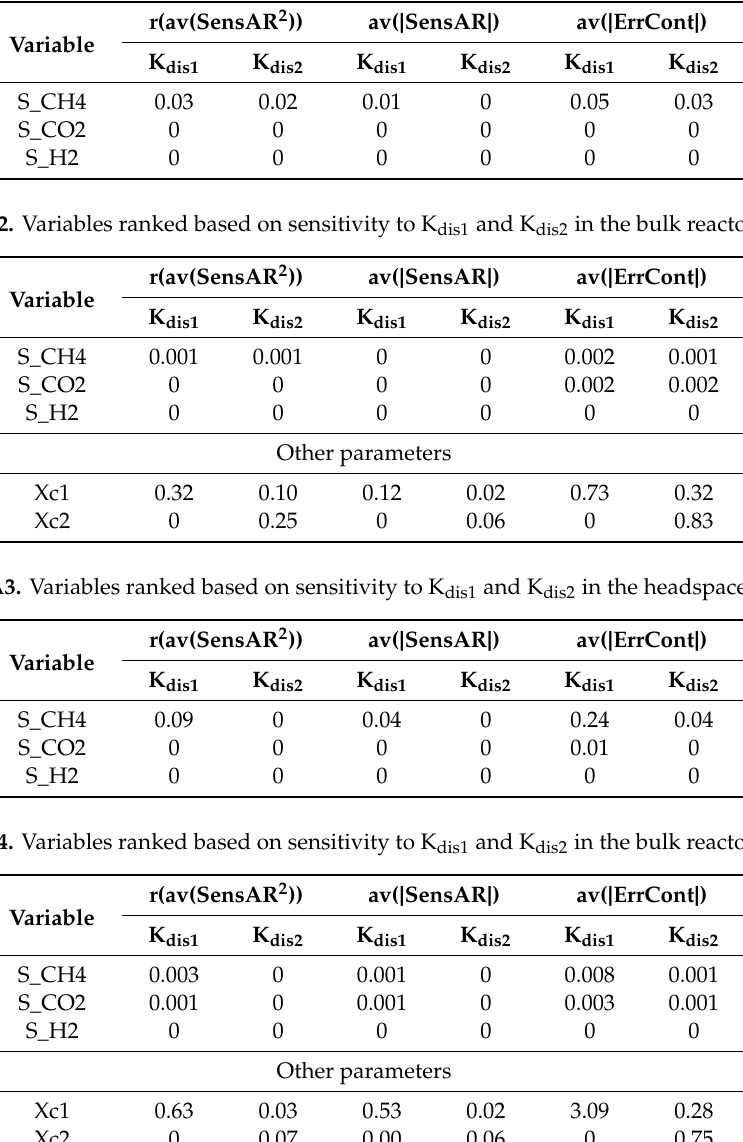
Table A1. Variables ranked based on sensitivity to K dis1 and K dis2 in the headspace (RF).